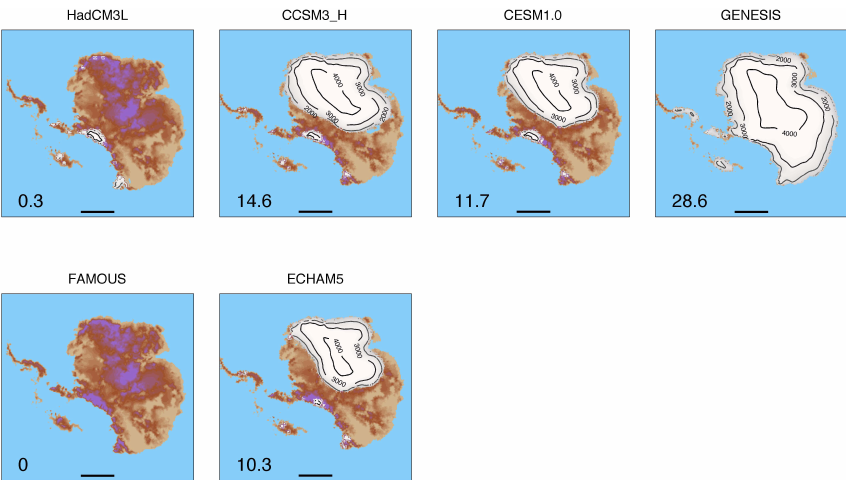
Fig. 2. Offline 2 × PIC simulations of the Antarctic ice sheets forced by the HadCM3L early Eocene simulation of Lunt et al. (2010), CCSM3_H simulation of Huber and Caballero (2011), CESM1.0 simulation of Goldner et al. (2013), GENESIS simulation of DeConto et al. (2008), FAMOUS simulation of (Sagoo et al., 2013) and ECHAM5 simulation of Heinemann et al. (2009). Bedrock scale same as in Fig. 1, total ice volumes shown on Figures are in 10 6 km 3 .